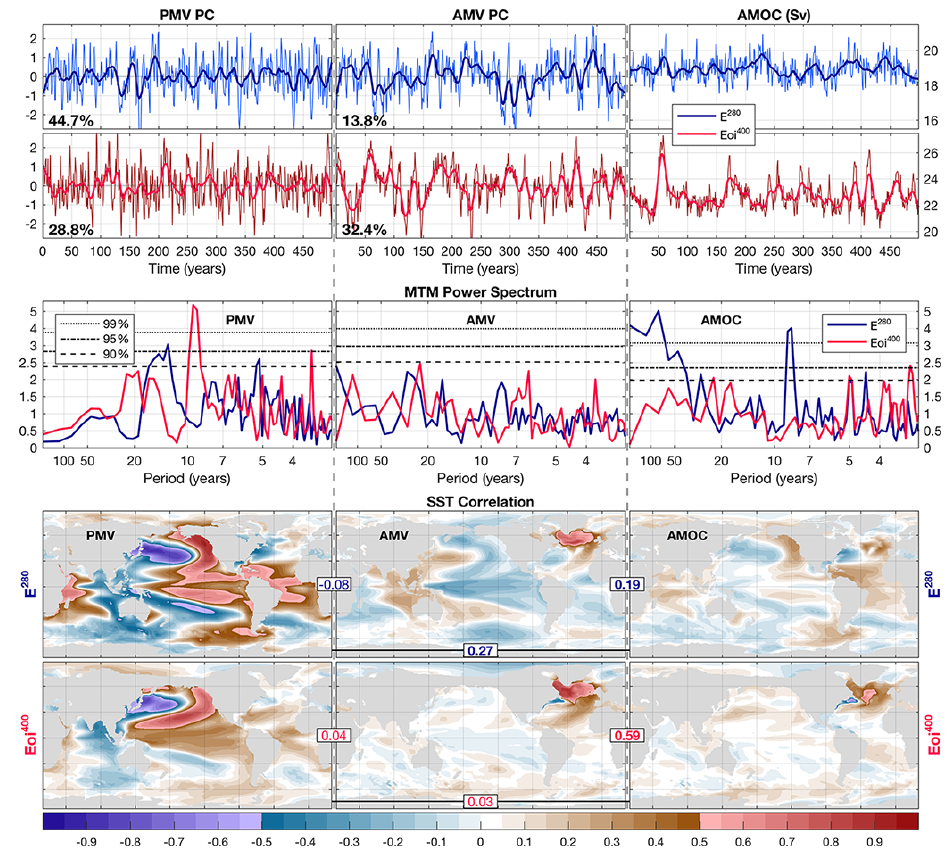
Figure 13. Time series (upper panels; thick lines using a 20-year smoothing window), multi-tapered power spectra (middle panels), and spatial correlation patterns (lower panels) of North Pacific SST (left), North Atlantic SST (middle), and AMOC strength (right) variability for 500 years of annual SST data from our E 280 (blue) and Eoi 400 (red) simulations. The percentage of variance explained by the respective principal component is shown in black alongside the PMV and AMV time series. Spatial SST patterns show the temporal correlation between the SST at each location and the different variability indices. Boxed numbers also indicate the total correlation between each of these indices (i.e. time series in the upper